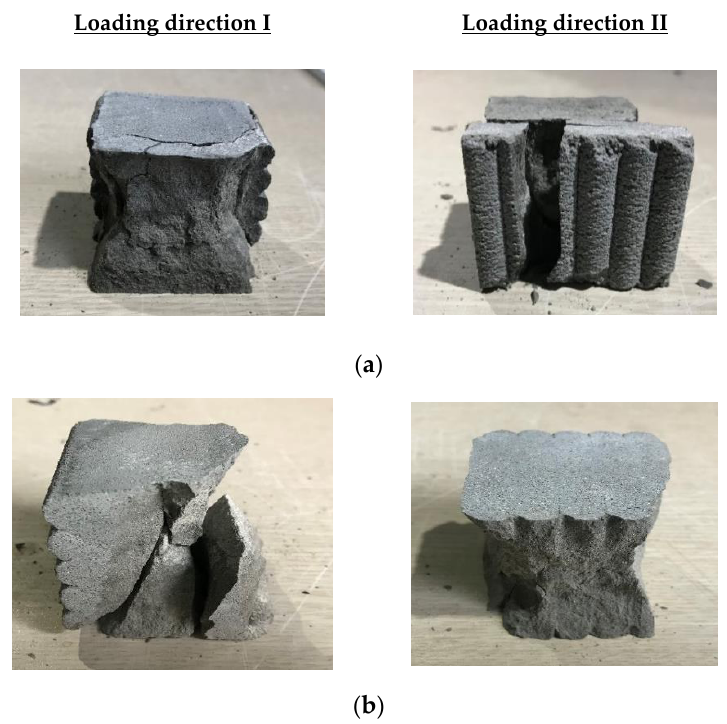
Figure 15. Compressive failure patterns of mortar samples under loading directions I and II. ( a ) Water-cured specimens; ( b ) Air-cured